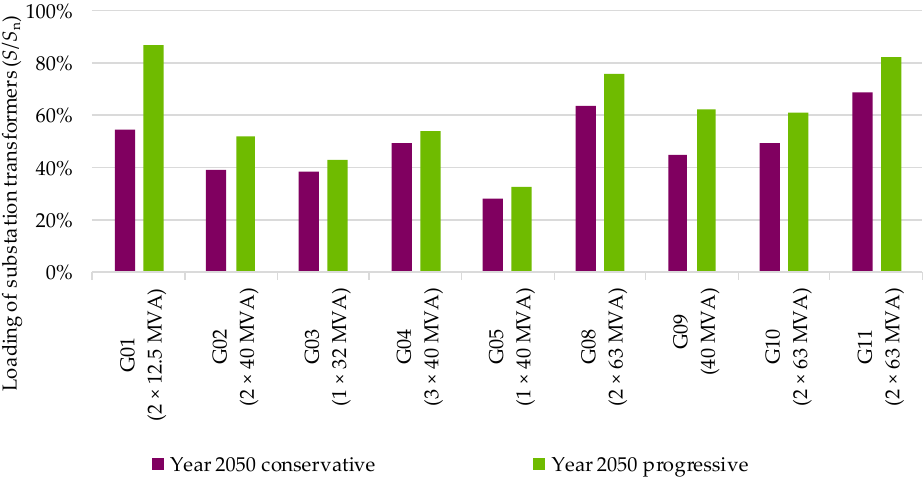
Figure 16. Loading of substation transformers for 9 medium voltage grids in the year 2050 for the two development scenarios.